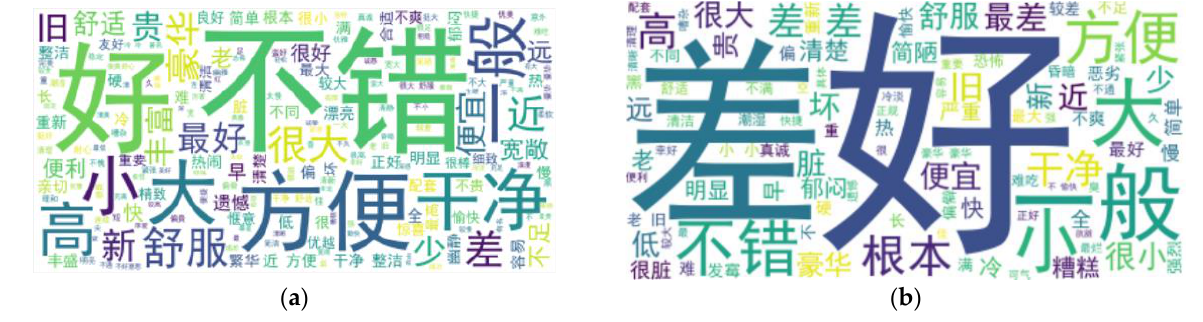
Figure 4. ( a ) Positive word cloud map; ( b ) negative word cloud map.